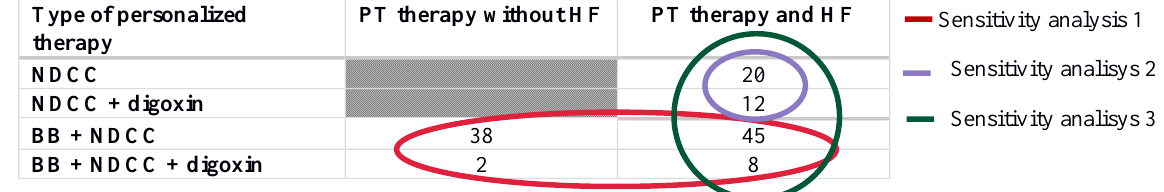
Table 2. Patients in the PT group sorted according to therapeutic regimens. BB (beta-blockers), HF (heart failure), NDCC (non-dihydropyridine calcium channel blockers), PT (patient-specific